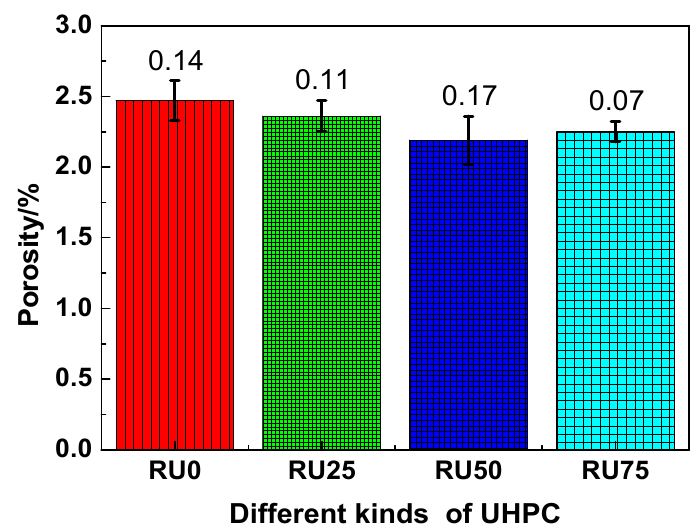
Figure 3. The porosity of RS-UHPC with different contents of GO.